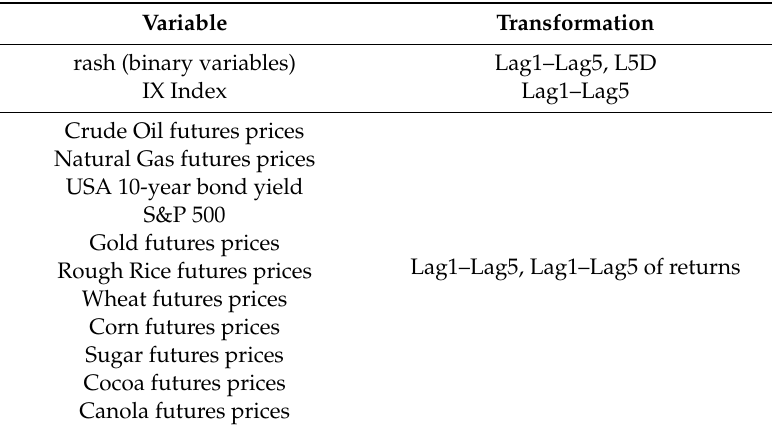
Table 2. Extended variables. Returns are the log returns.